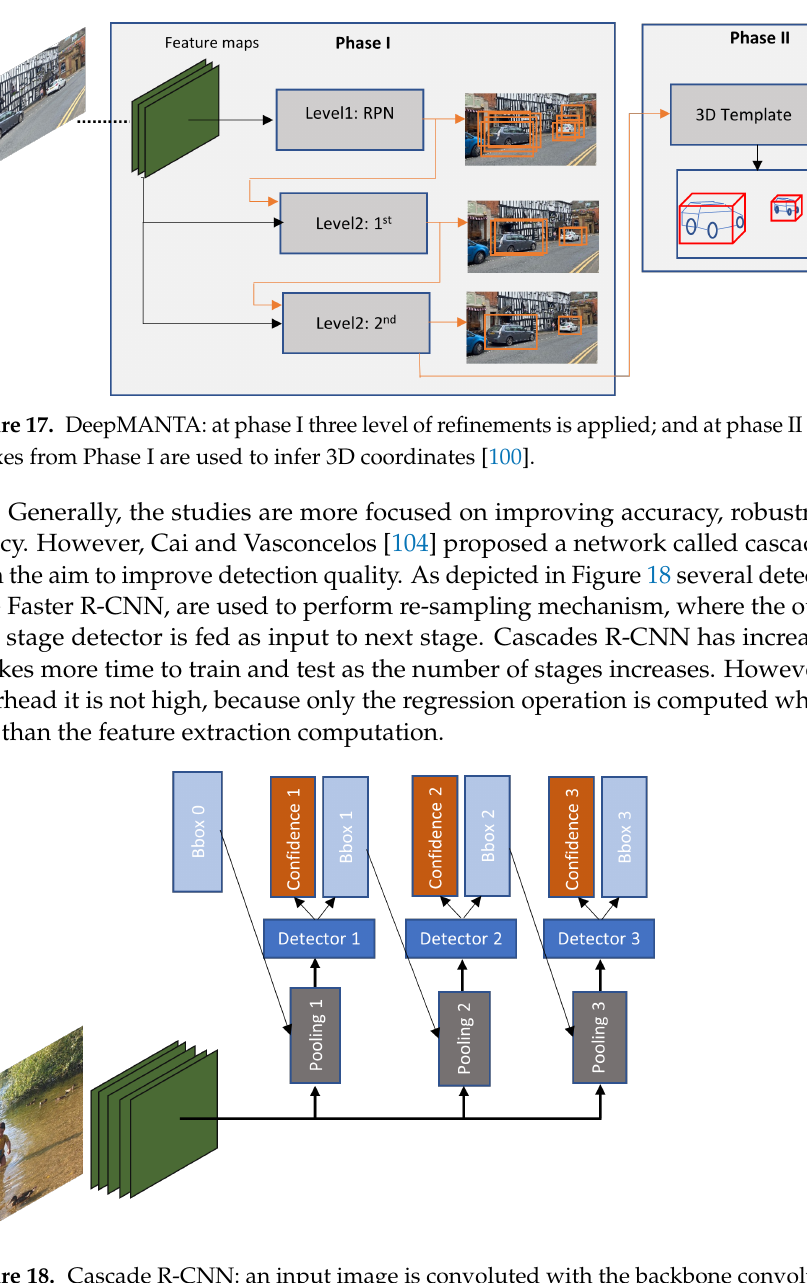
Figure 18. Cascade R-CNN: an input image is convoluted with the backbone convolutions layers (green), then three different pooling (grey) are applied in the convoluted image. Each one of the three pooled feature maps are fed into different detectors(dark-blue). The detectors then predict the class of the objects(orange) and their respective bounding box(light-blue). Notice that the predicted bounding box "bbox X" from the previous detector is fed as input to the next detector. This cascade approach enables the network to train with a higher IoU threshold which increases the detector quality